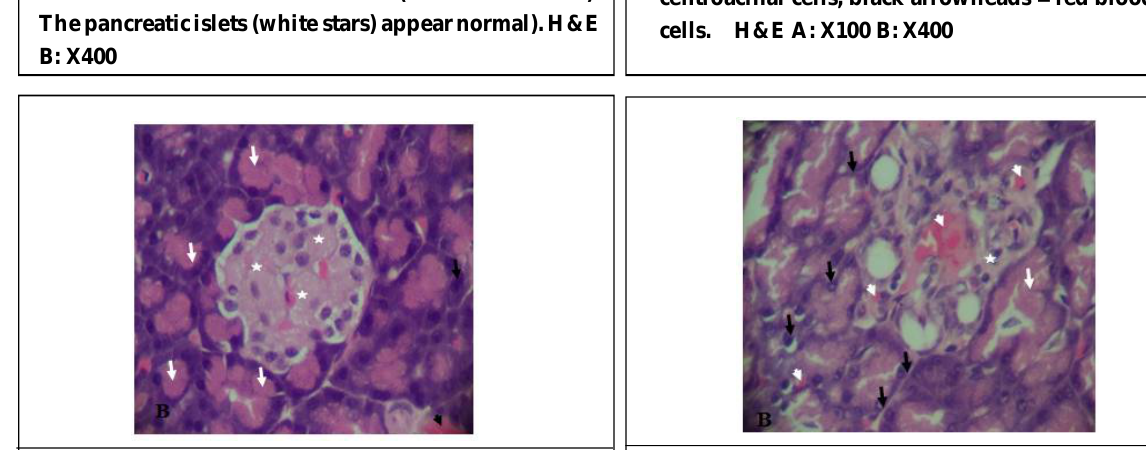
Plate 2 (Group 2): Pancreas of Wistar rat, induced with diabetes and treated with 200 mg/kg b.w of plant extract, presenting with normal tissue morphology. White stars = pancreatic islets, Black arrows = secretory acinar, white arrows = centroacinar cells, black arrowheads = red blood cells. H&E A: X100 B: X400